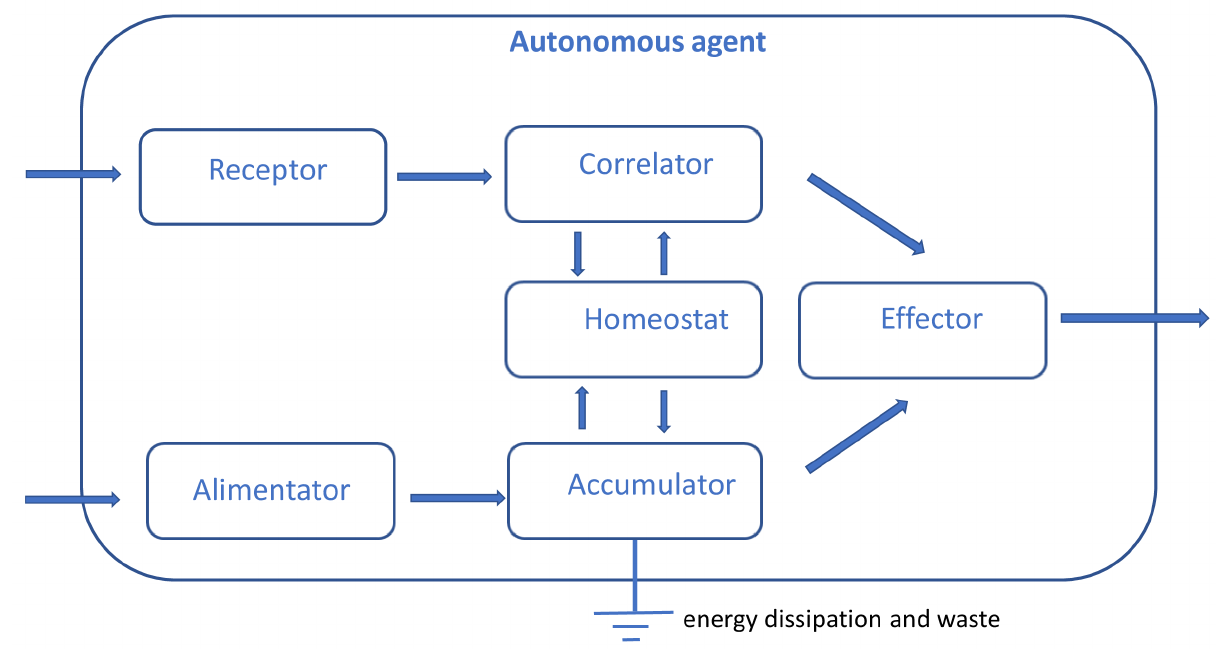
Figure 1. The structure of the autonomous system (autonomous agent) according to